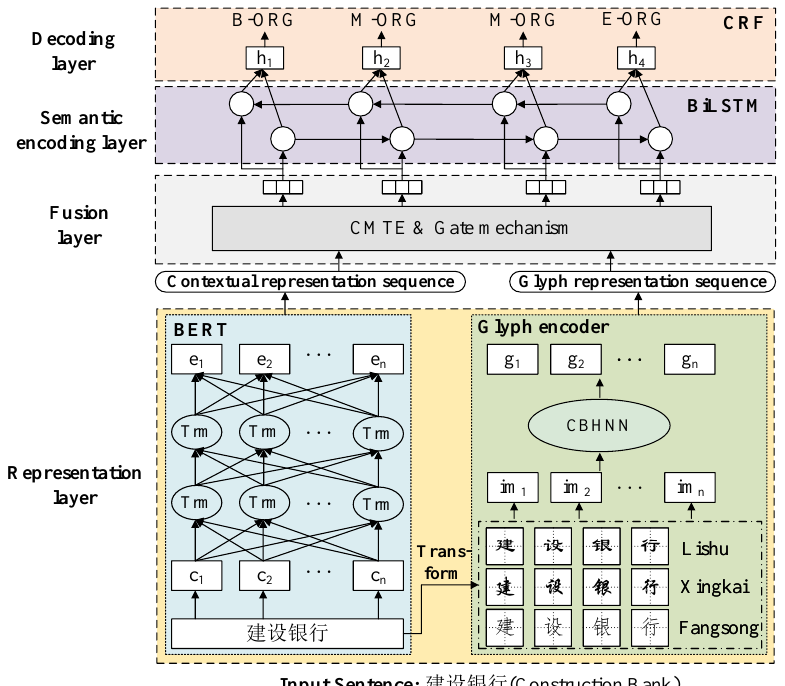
Figure 1. The overview of the proposed CGR-NER